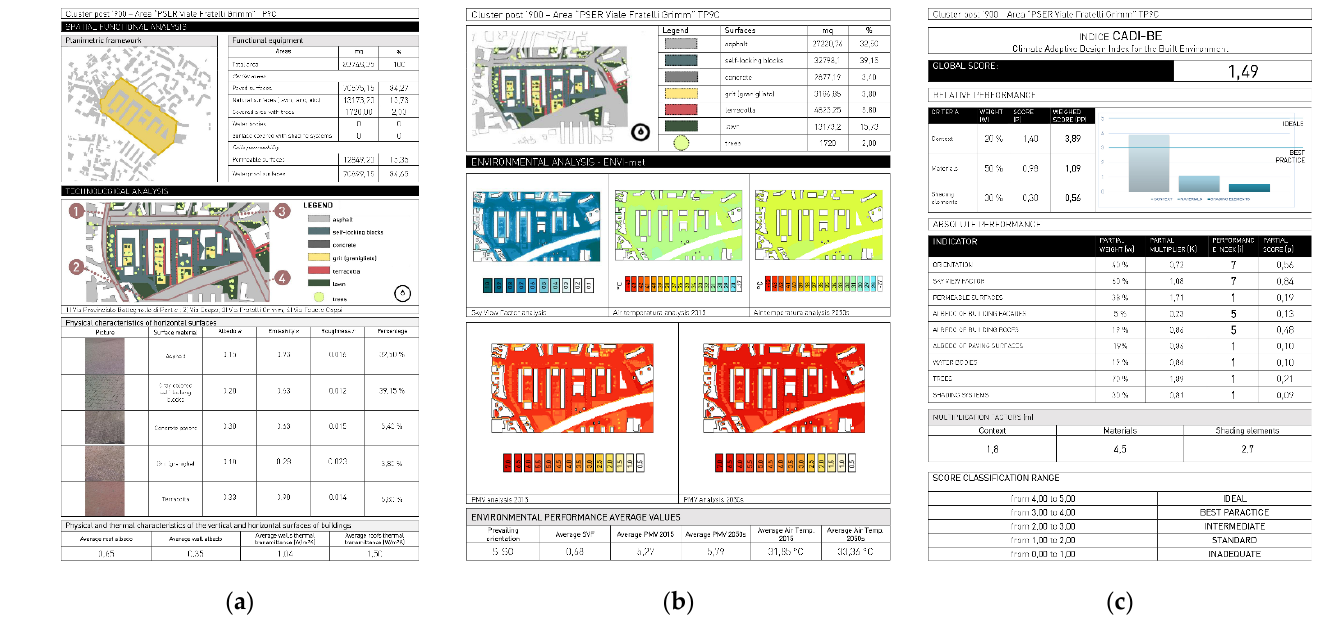
Figure 15. Registration of the TP9C test area in the actual condition: ( a ) technological analysis; ( b ) environmental analysis; ( c ) CADI-BE output.